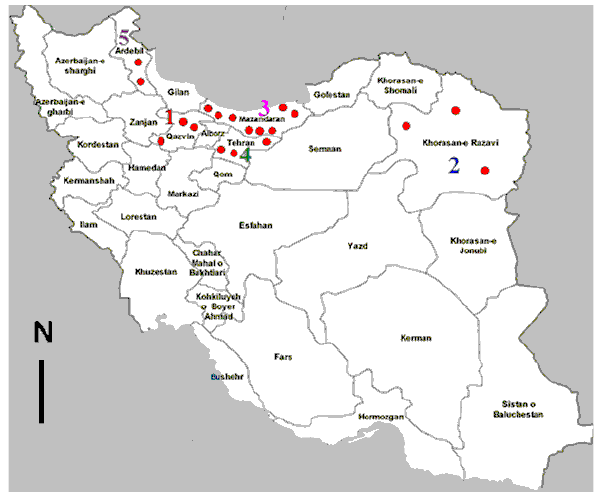
Figure 1. Distribution map of the studied